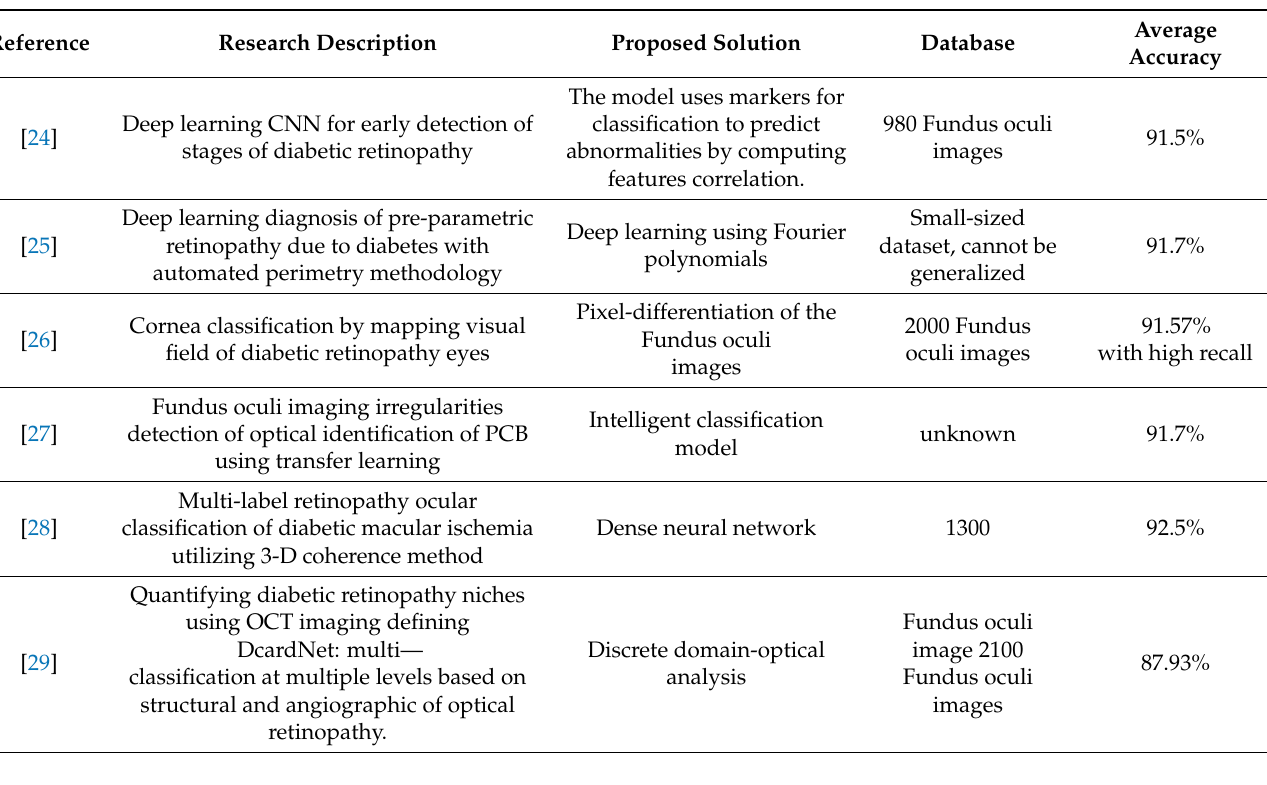
Table 1. Recent research in diabetic retinopathy prediction intelligent